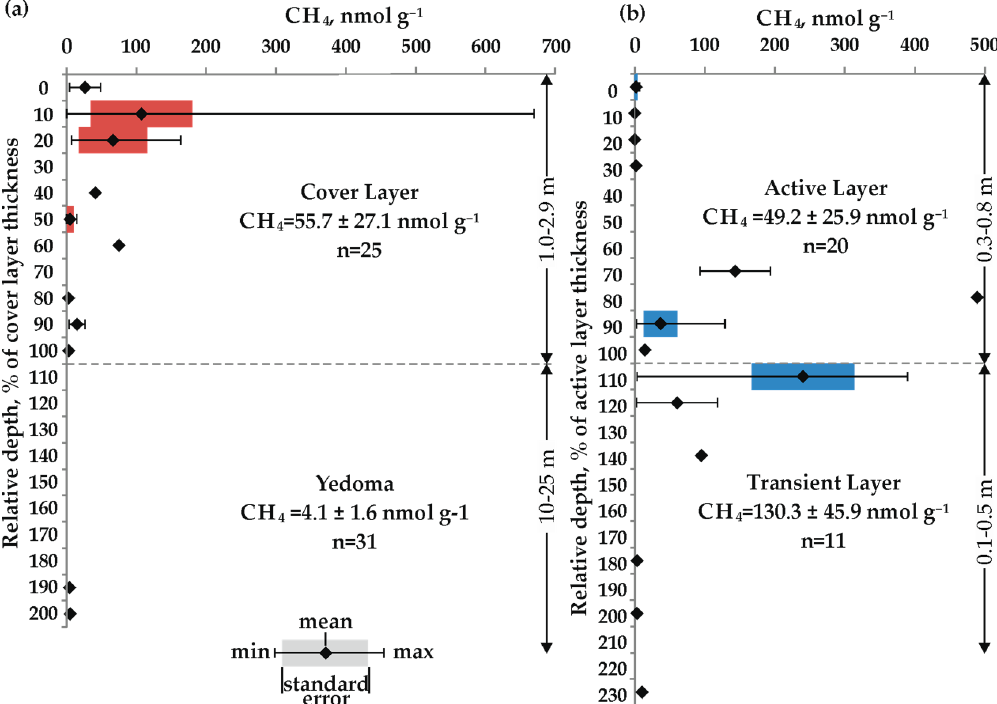
Figure 3. CH 4 concentrations averaged by relative depth in the uppermost permafrost and active layer. ( a ) Yedoma and the Cover Layer (normalized by the Cover Layer thickness at the sampling sites). ( b ) Active layer and rarely thawed transient layer (normalized by the maximal annual thawing depth at the sampling sites). CH 4 was sampled from the permafrost in northeastern Siberia in 2004–2008 (Tables A2 and A3).